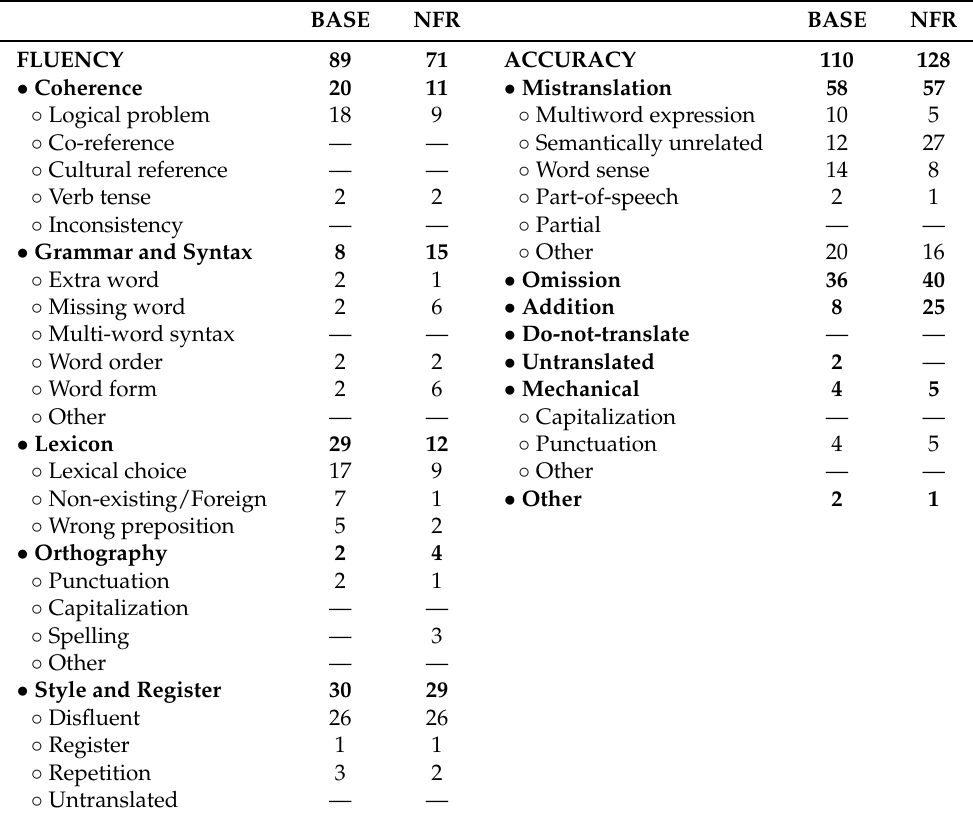
Table 11. Number of errors per category of the SCATE error taxonomy, for the baseline NMT and NFR